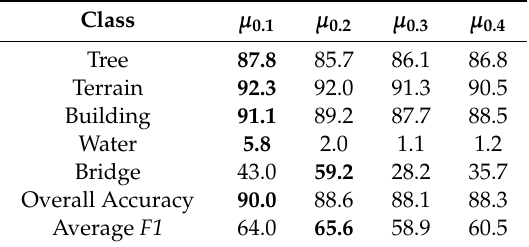
Table 2. SPG results for the testing area. The F1 score is used to evaluate the performance. Bold numbers show the highest values within di ff erent parameters.